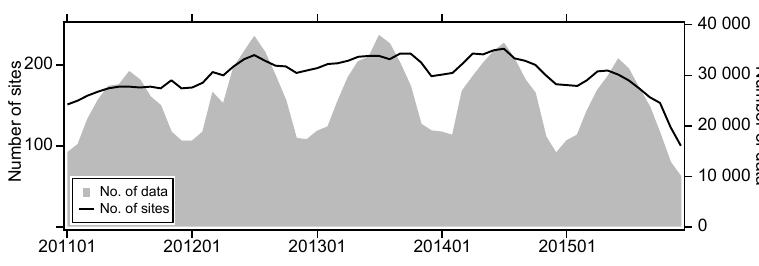
Figure 4. Time series of the number of monthly AERONET AOD data (gray shading) and the number of AERONET sites (thick black line) used in the evaluation.